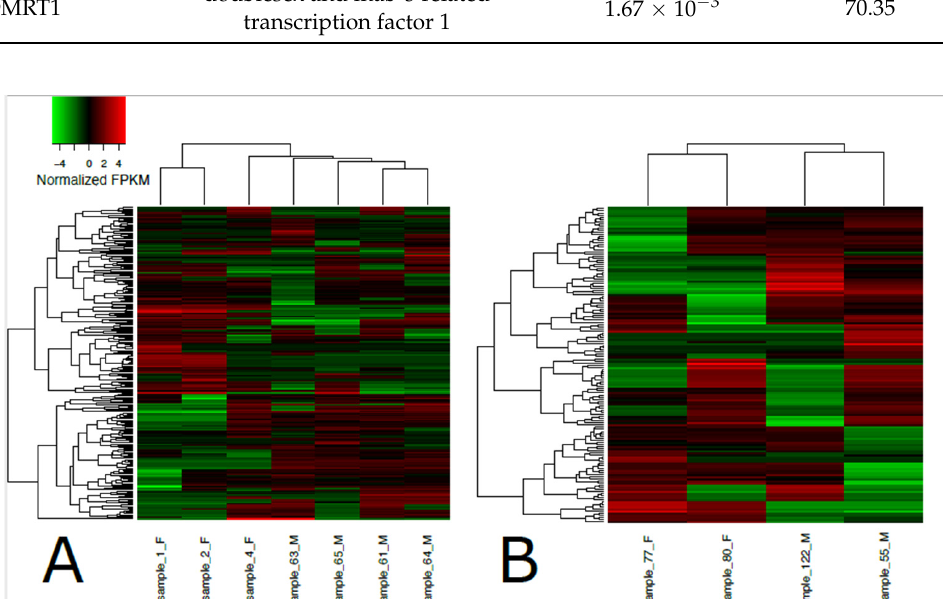
Figure 1. Differentially expressed transcripts in brain and gonadal tissue in loggerhead sea turtles reared below and above 29 °C. Significant differentiation from fold change (FC) of two is indi- cated in red (FDR < 0.001). In brain ( A ), 774 and 1513 transcripts are significantly up- and downreg- ulated with fold change greater than 2; 1270 and 872 transcripts with fold change greater than 2 are significantly up- and downregulated in gonads ( B ).